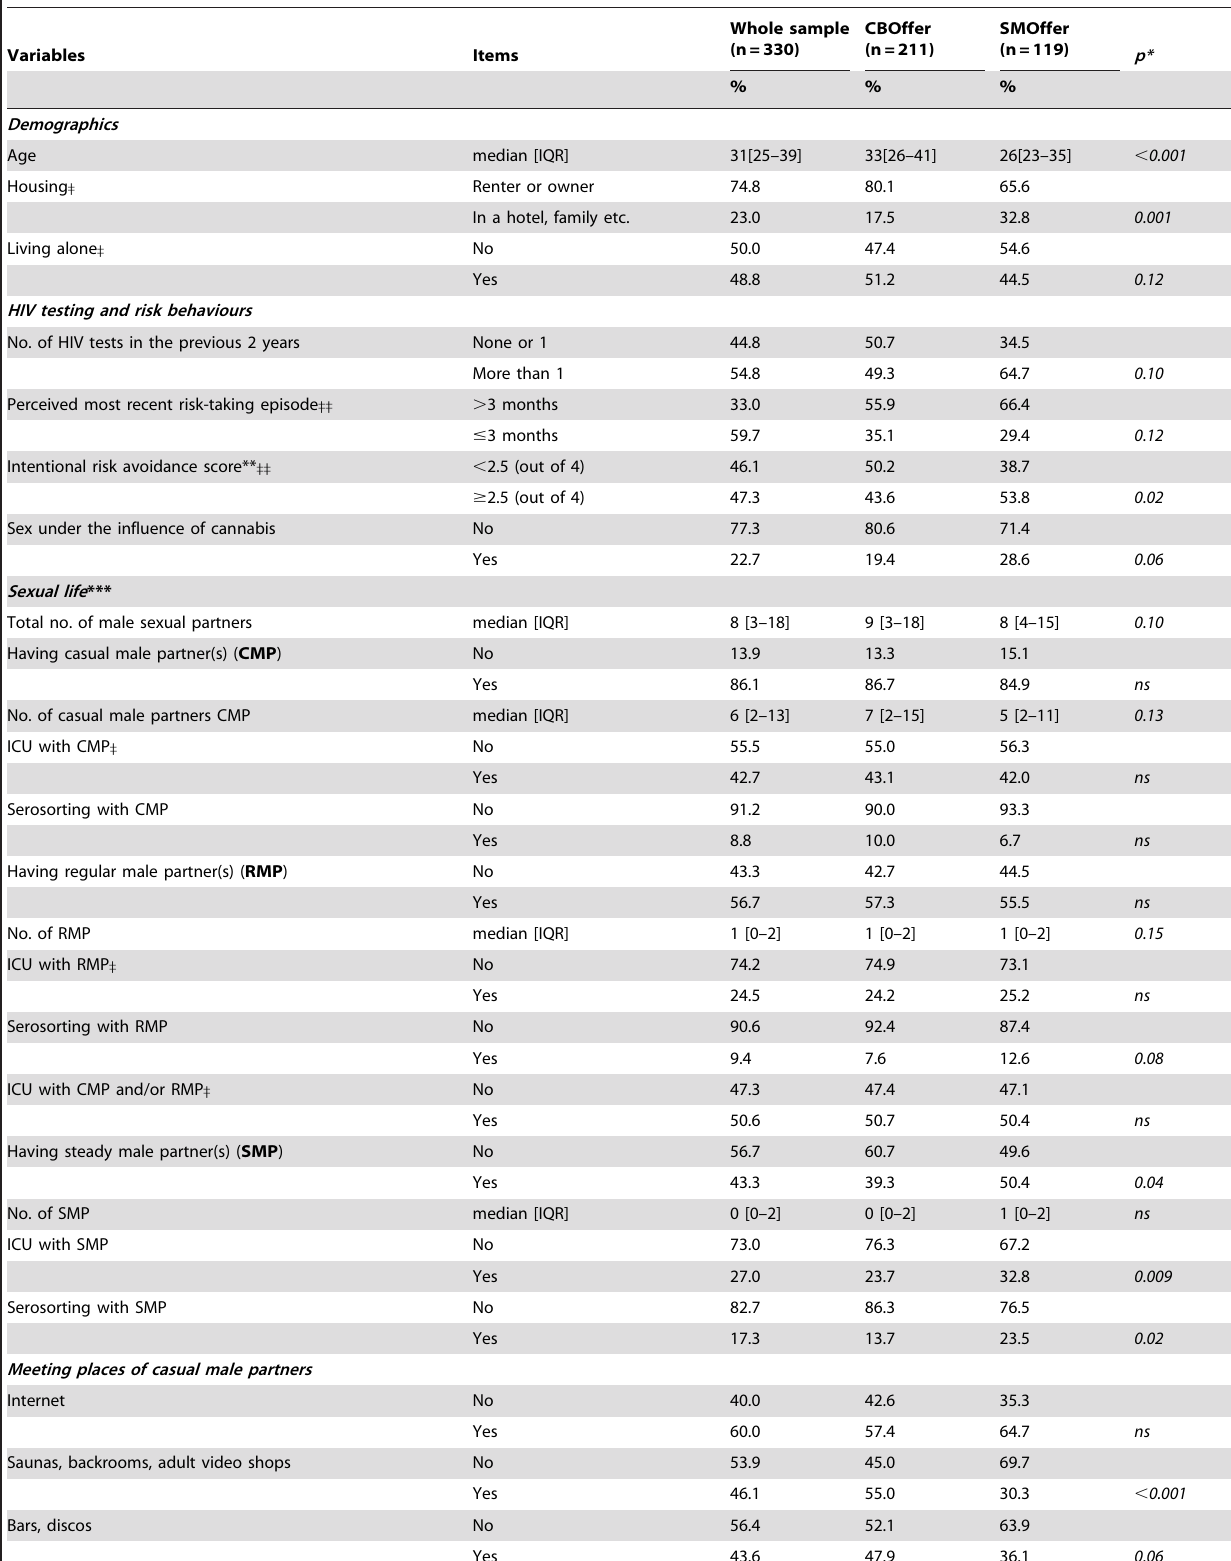
Table 2. Comparisons of the characteristics of men who have sex with men accessing the standard medicalized testing offer with those accessing the community-based non-medicalized testing offer (univariate analyses, n =330).